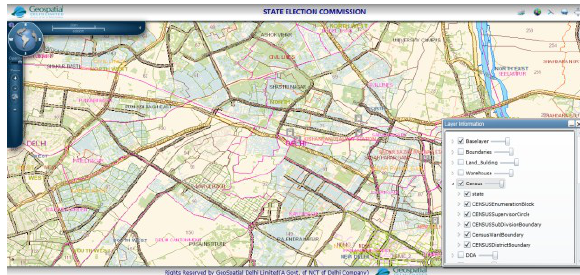
Figure 2 GMPDW, Front Page (Thematic Map)